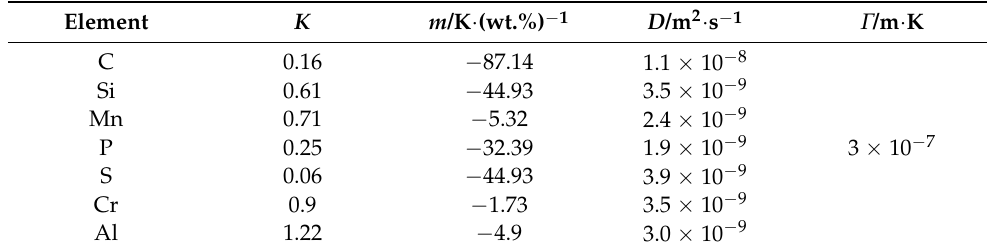
Table 3. Liquidus slope, solute partition coefficient, diffusion coefficient and Gibbs-Thompson coefficient of binary Fe-X steels.